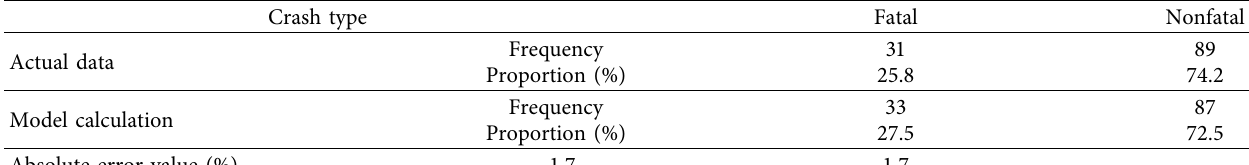
Table 8: Accuracy of the model.